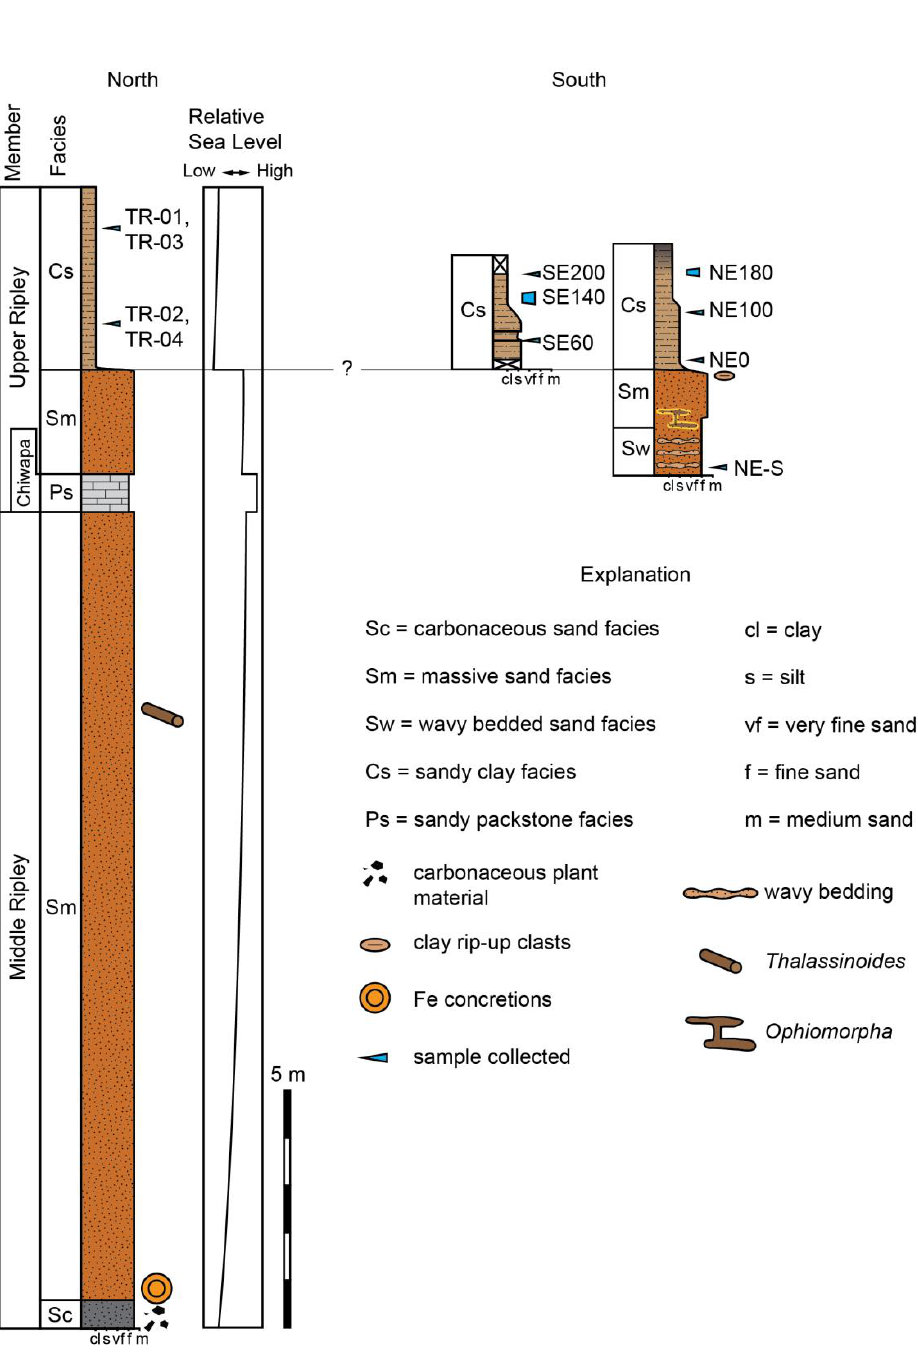
Figure 4. Stratigraphic sections measured at the northern and southern sites, including sample collection locations, lithofacies designations, and interpreted relative sea-level curve. locations, lithofacies designations, and interpreted relative sea-level